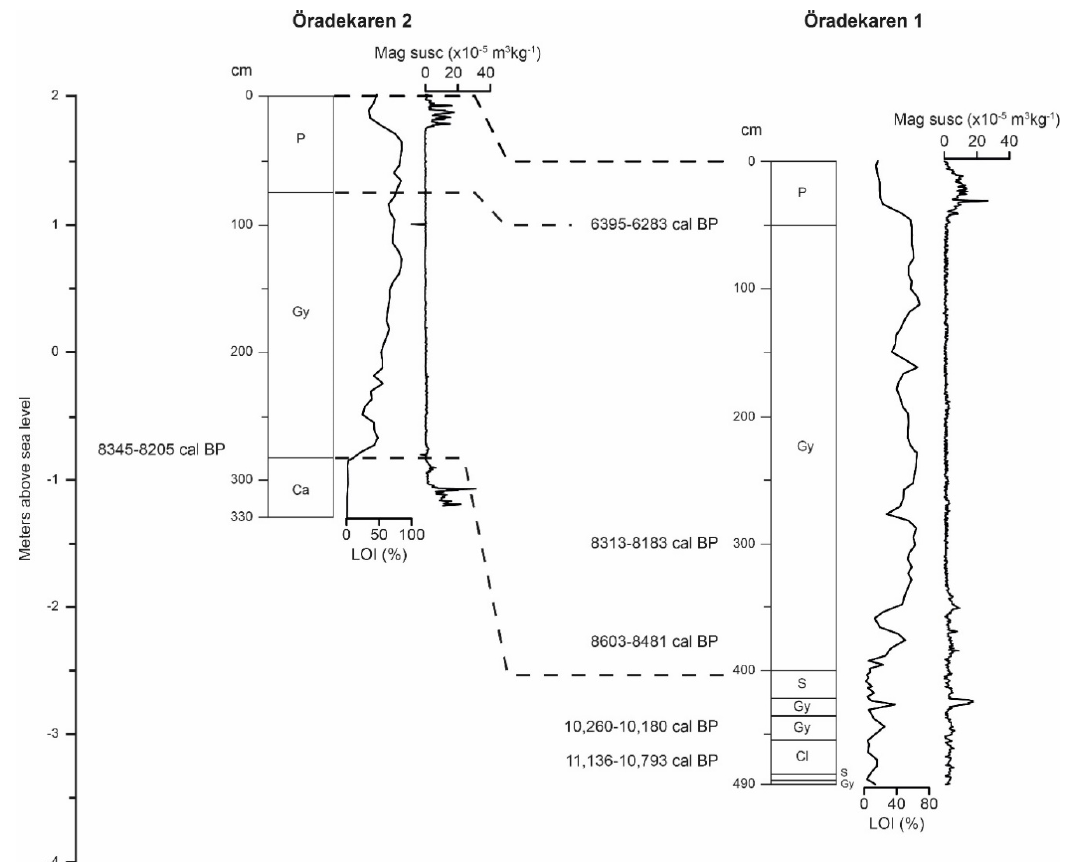
Figure 4. Simplified lithostratigraphic columns, loss-on-ignition (LOI) and magnetic susceptibility from the Öradekaren 1 and Öradekaren 2 sequences. Facies abbreviations: P = fen peat, Gy = gyttja, Ca = calcareous sediment, S = sand, Cl = clay. Dashed lines indicate the proposed correlation between the sequences based on lithostratigraphic changes (Tables 1 and 3) and 14 C dating (Table 2).